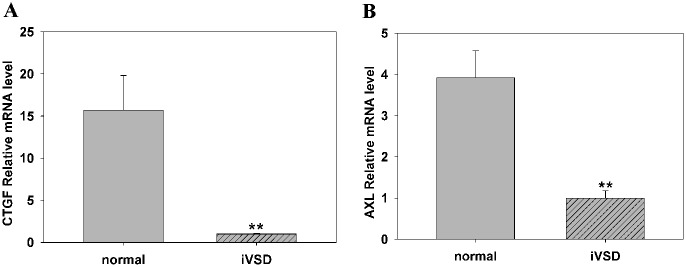
Downstream targets of YAP1 are significantly lower in iVSD hearts compared to control hearts.GAPDH served as a control. (A) CTGF and AXL relative mRNA levels were significantly lower in iVSD compared to control subjects. GAPDH served as a control. Data presented as means ± SD. The Student’s t-test was performed to evaluate statistical significance, iVSD group: n = 20, control group: n = 6, **p<0.01.